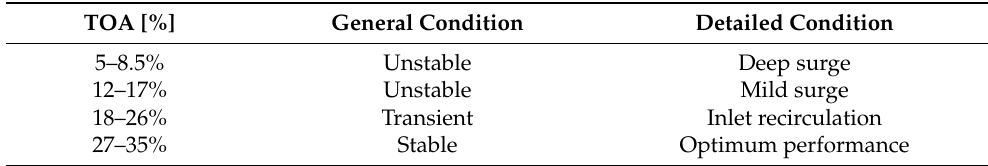
Table 1. TOA values and corresponding operating